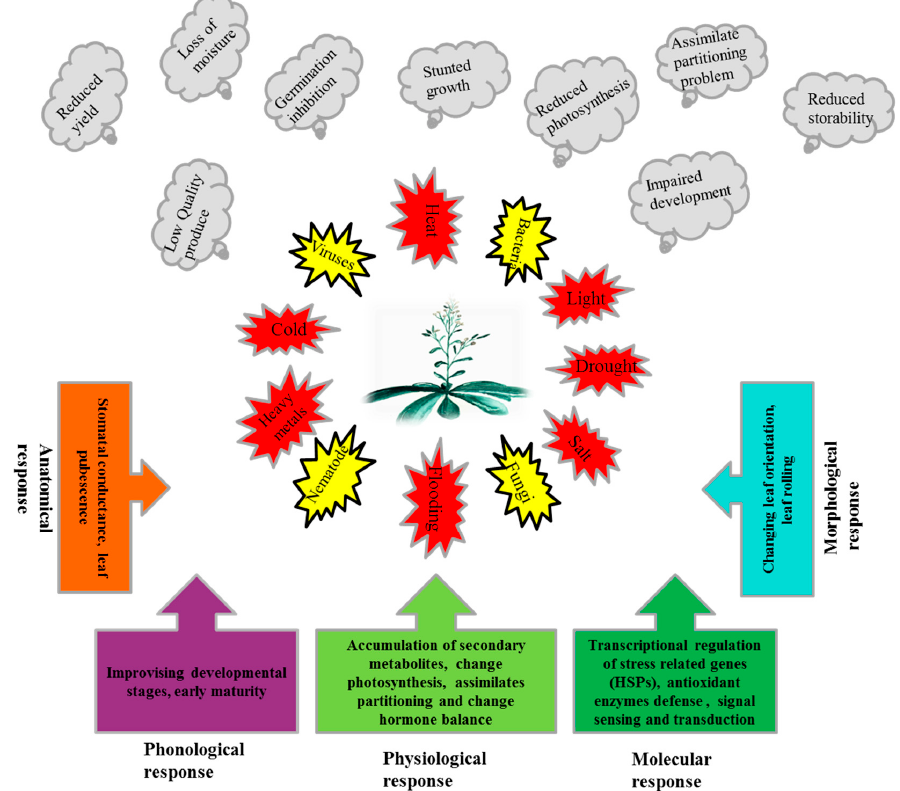
Figure 1. Exposures of plants to different biotic and abiotic stresses, adverse effects of these stresses on plants and response mechanisms of plants to these stresses.